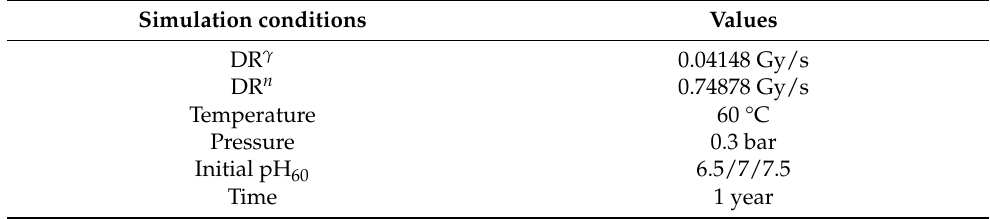
Table 3. Conditions assumed for